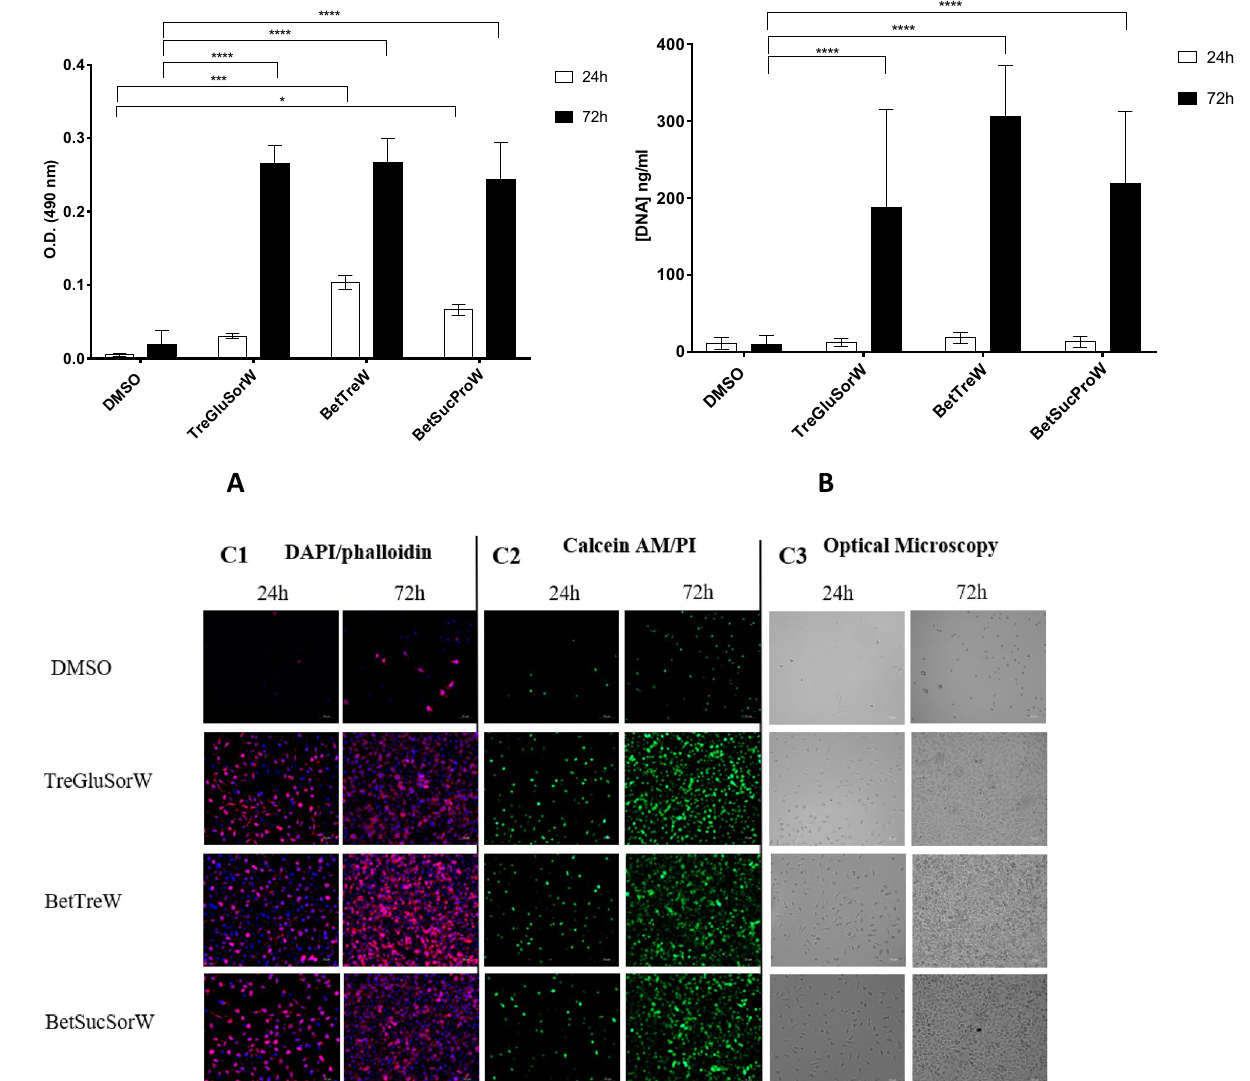
Figure 2. Assessment of the post-thawing recovery of L929 cells. MTS assay ( A ) and DNA Assay ( B ) after 24 h, 48 h, and 72 h of culture.Data represent means ± SD (n = 3). Statistically significant differences were determined by Dunnett’s multiple comparisons test and are represented in asterisks: * p < 0.05; *** p < 0.005 and **** p = 0.0001, two-way ANOVA. The absence of asterisks means that there are no significant differences when compared with values of DMSO or other NADES at the corresponding time points. Post-thawing DAPI/ Phalloidin assay (cells nuclei were stained blue by DAPI and F-actin filaments in red by phalloidin) ( C1 ), Live/ Dead fluorescence assay (living cells were stained green by calcein AM and dead cells red by PI) ( C2 ) and Optical microscopy ( C3 ) of L929 cells at 24 h and 72